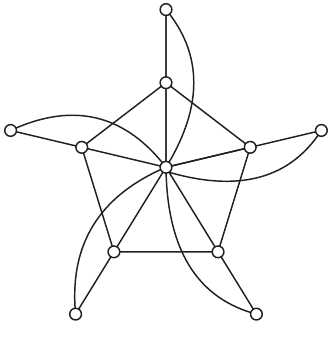
Figure 15. The flower graph F 5